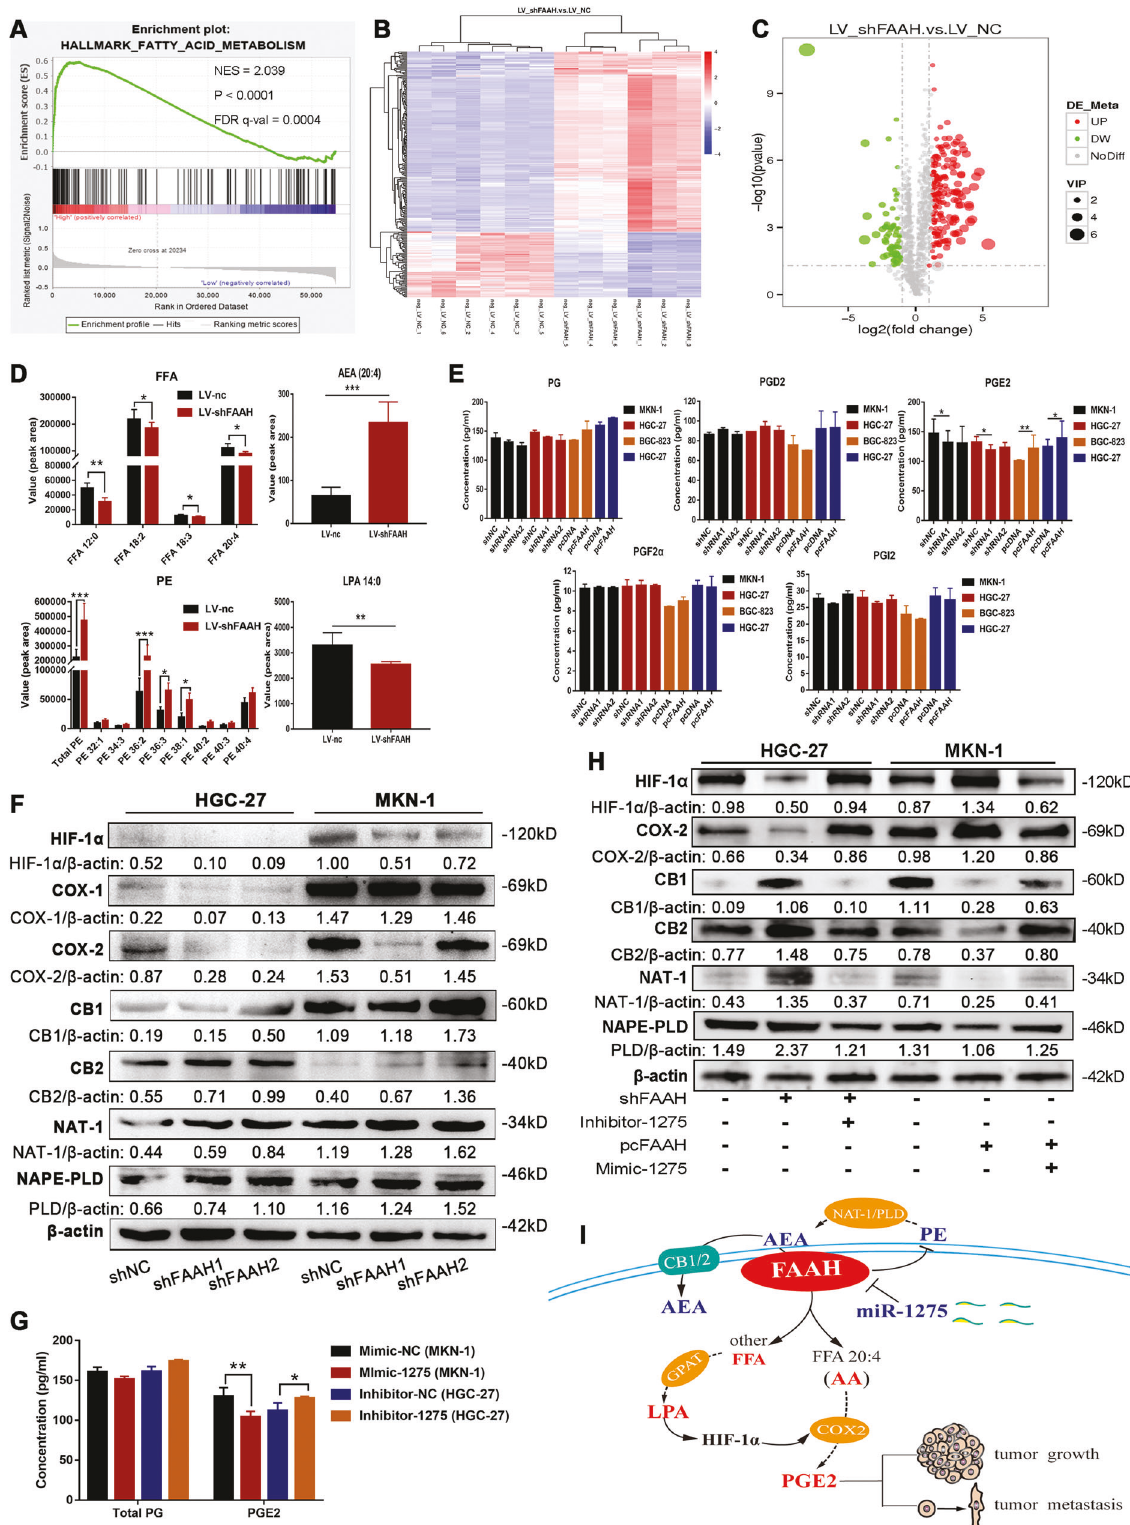
Immuno fl uorescence- fl uorescence in situ hybridization (IF- FISH) assay Cells were seeded on glass coverslips at a density of 3 × 10 5 /mL and cultured for 24 h. Then 2 mL of 4% paraformaldehyde was added to fi x the